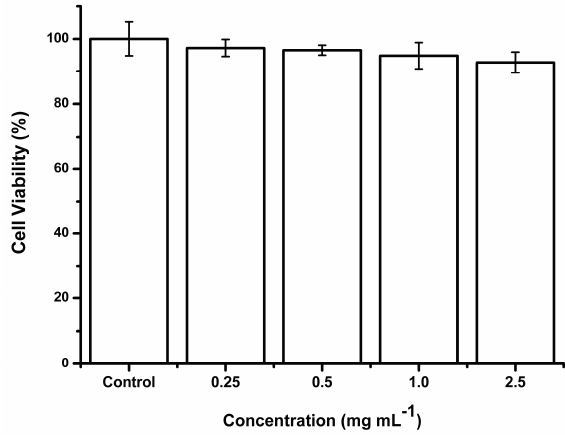
Figure 2. 293T cells were cultured overnight for adherence and then treated with prepared ethosomal gels at different concentrations from 0.25–2.5 mg·mL − 1 for 24 h.